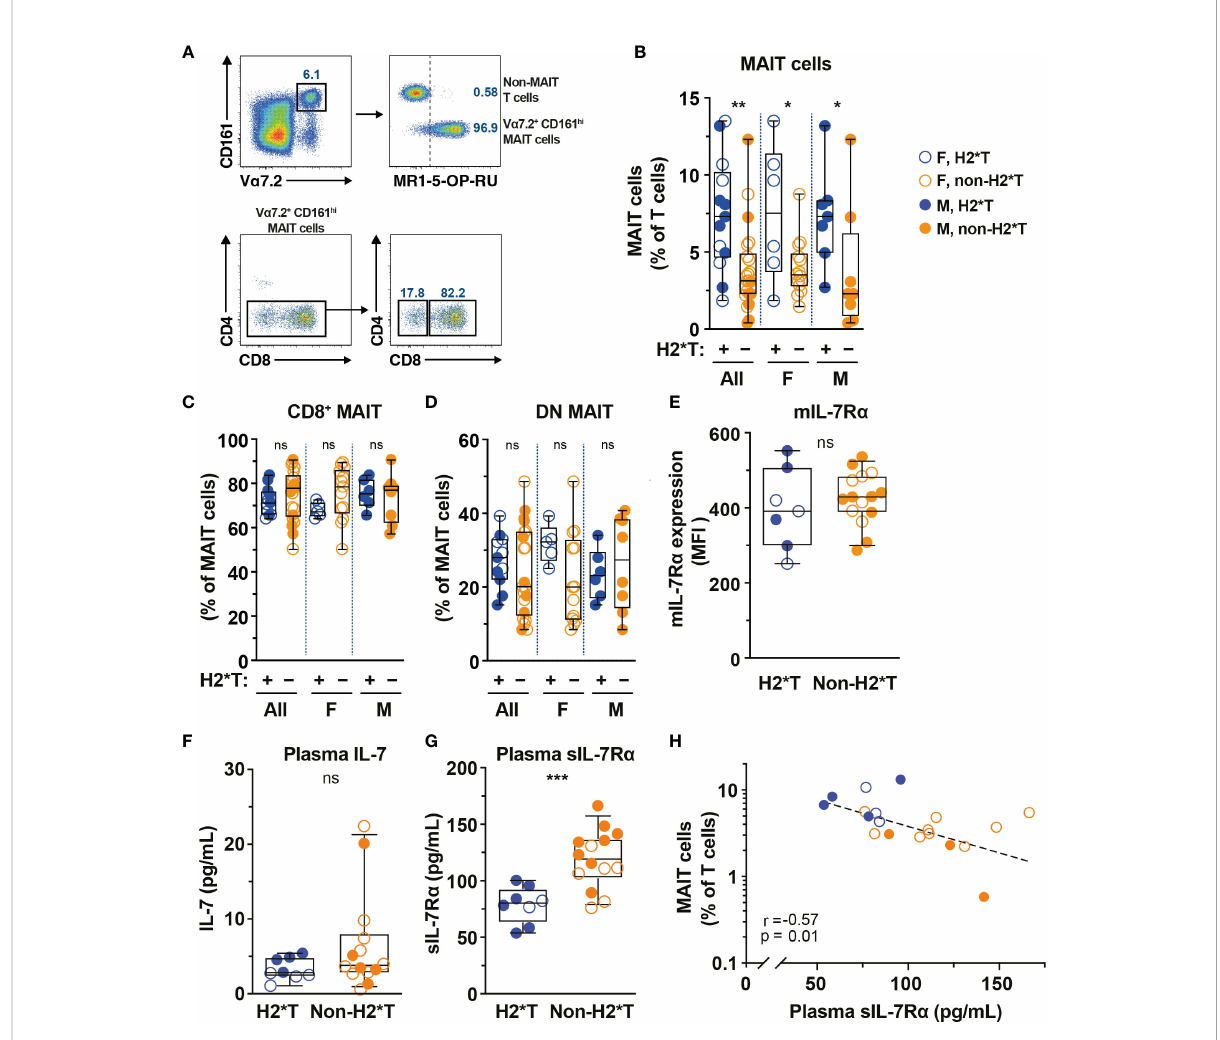
FIGURE 1 MAIT cell levels are higher in HIV-1-uninfected individuals carrying the IL7RA haplotype 2. (A) Representative fl ow cytometry gating strategy to identify MAIT cells by TCR V a 7.2 and CD161 co-expression on T cells (V a 7.2 + CD161 hi MAIT cells), as well as the CD4 and CD8 co-receptor expression. MR1-5-OP-RU tetramer staining was used to con fi rm the identity and MR1-restriction of V a 7.2 + CD161 hi MAIT cells. (B – E) MAIT cell levels (B) , the distribution of CD8 + (C) and CD4 - CD8 - (DN; D ) MAIT cell subsets, and membrane-bound (m)IL-7R a I levels by MAIT cells in HIV- 1-uninfected individuals bearing the different IL-7R a haplotypes. (F, G) Plasma levels of IL-7 (F) and soluble (s)IL-7R a (G) in HIV-1-uninfected individuals bearing the different IL-7R a haplotypes. (H) Spearman ’ s correlation between circulating MAIT cell levels and plasma sIL-7R a . Box and whisker plots show all data points (N=7-13 for haplotype 2 individuals and N=14-22 for non-haplotype 2), median, and the interquartile range. Statistical signi fi cance was determined using Mann-Whitney ’ s test (B – F) or unpaired t-test (G) . Correlations were assessed using the Spearman rank correlation (H) . *** p<0.001, ** p<0.01,* p<0.05. ns, not signi fi cant. F, female; M, male; H2*T, IL7RA haplotype